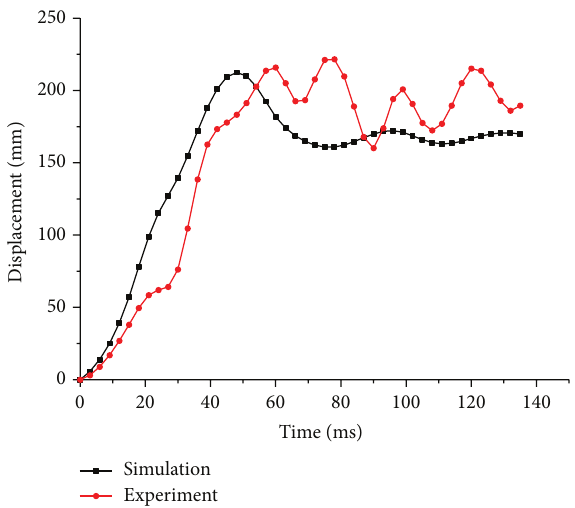
Figure 6: The history curves of midspan displacement from experiment and simulation.